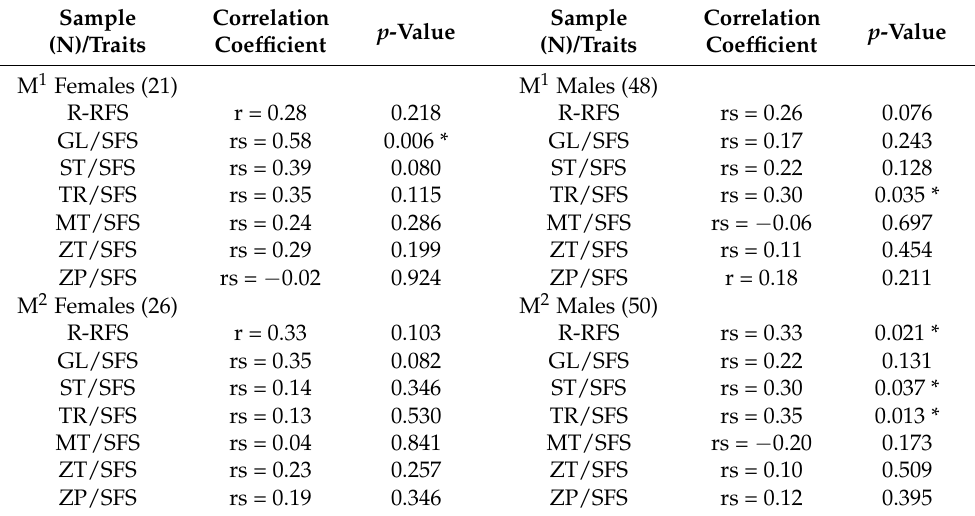
Table 5. Results of the correlation analysis between the relative total occlusal area (TOCA/SFS) of permanent upper molars and the traits of the facial skeleton analyzed in this study obtained for samples of female and male crania; rs—the value of Spearman’s rank correlation coefficient; r—the value of Pearson’s correlation coefficient. Sample Correlation Sample Correlation p -Value p -Value (N)/Traits Coefficient (N)/Traits Coefficient M 1 Females (21) M 1 Males (48) R-RFS r = 0.28 0.218 R-RFS rs = 0.26 0.076 GL/SFS rs = 0.58 0.006